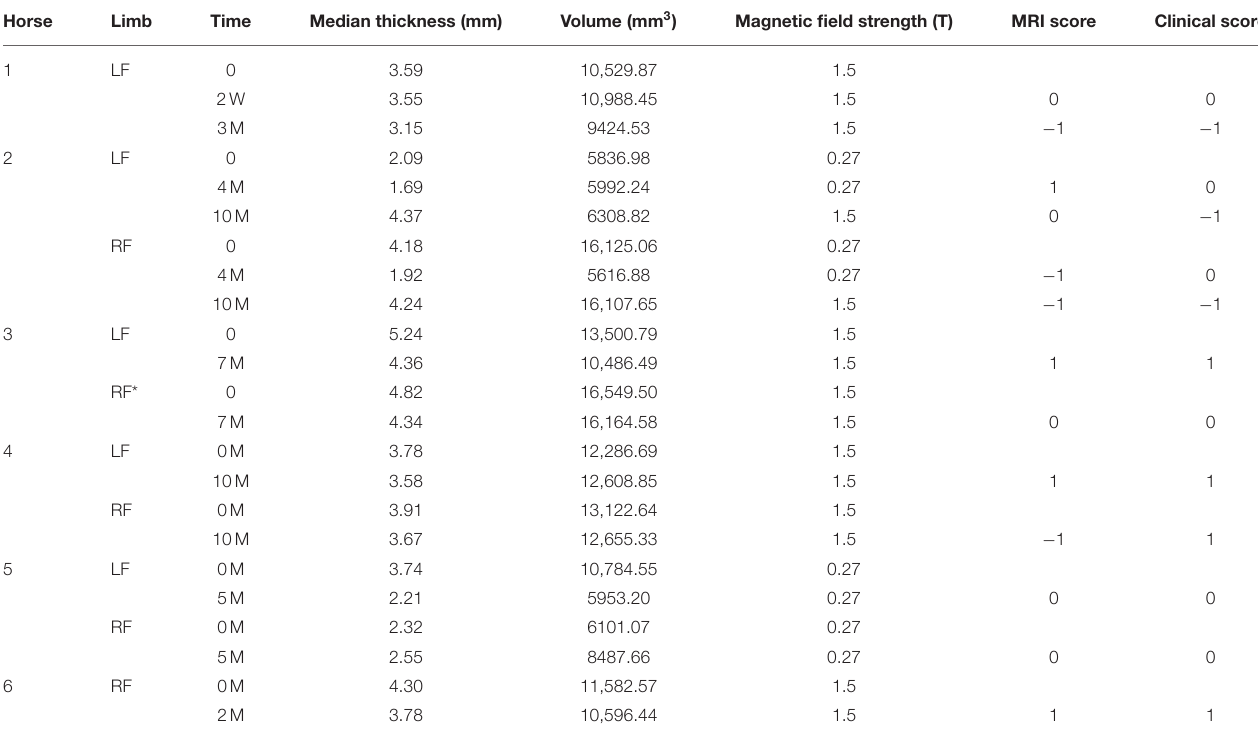
TABLE 1 | Summary data for each horse at each time point. Horse Limb Time Median thickness